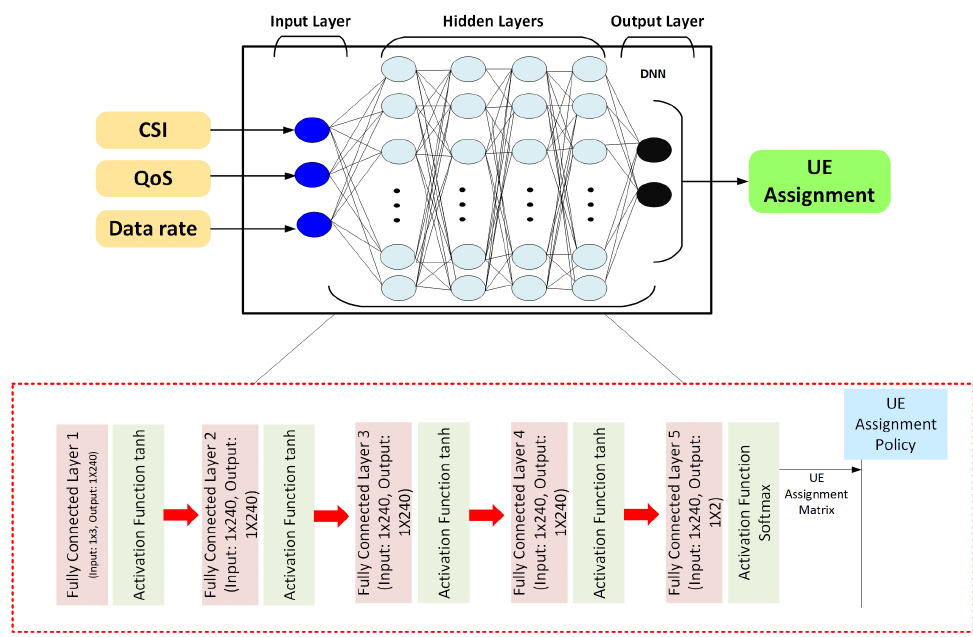
Figure 2. DL algorithm for user assignment to the PSN, LRN, and